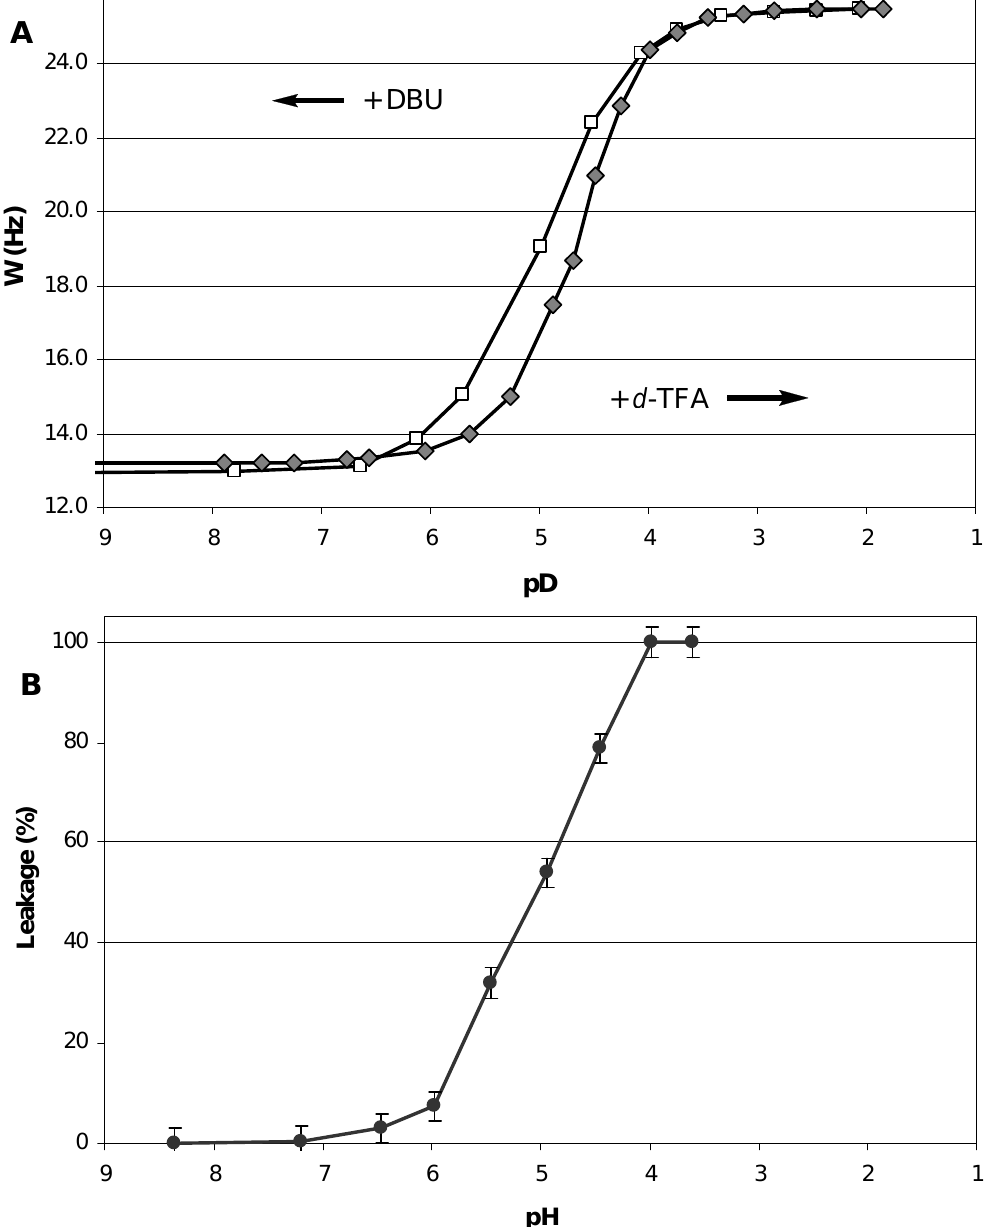
We explored the conformational chair-flip of lipid 1 (Figure 1) by 1 H NMR (600 MHz). The vicinal coupling constants 3 J between several protons attached to the cyclohexane moiety of 1 are HH